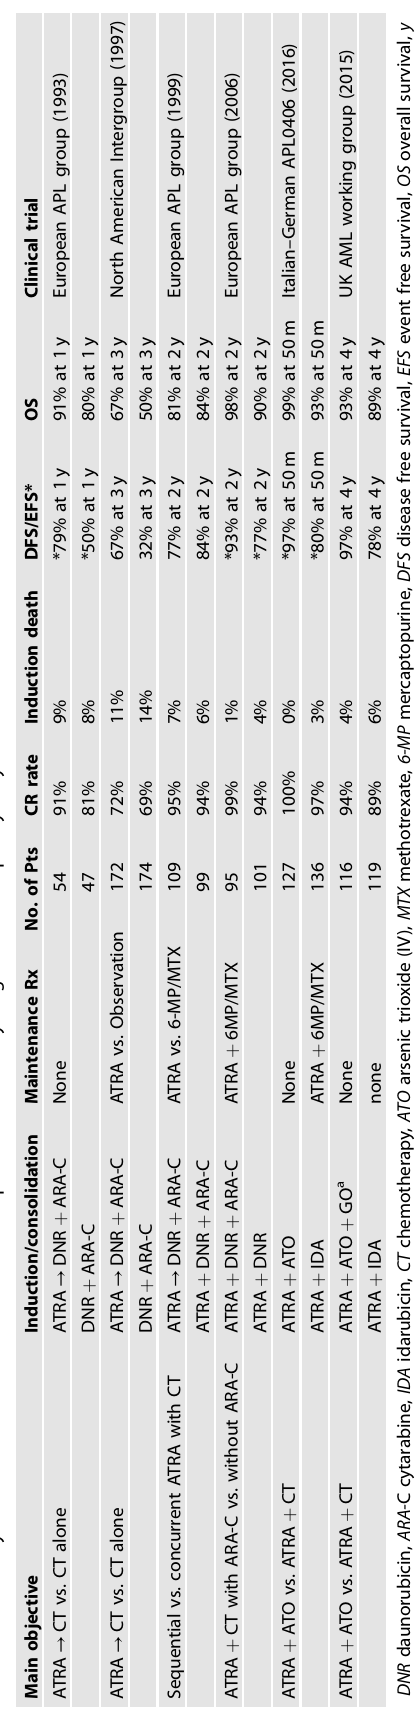
(Table 1). In the North American Intergroup Protocol study (I0129), 346 patients with newly diagnosed APL were randomized